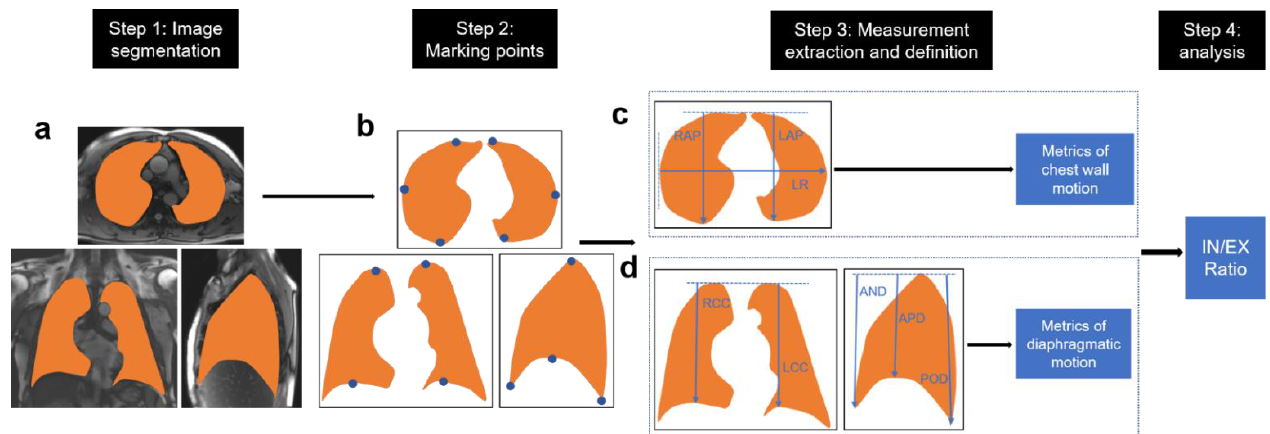
Figure 2. The flowchart of MR image processing and Measurements. MR image segmentation ( a ). Marking referenced points ( b ). Measurements extraction and definition ( c , d ). RAP, the anterior– posterior distance of right lung on the transversal plane; LAP, anterior–posterior (AP) distance of left lung on the transversal plane; LR, the left–right distance on the transversal plane; RCC, the cranial–caudal distance of right lung on coronal plane; LCC, the cranial–caudal distance of left lung on coronal plane; AND, the distance between the lung apex and anterior diaphragm on sagittal plane; APD, the distance between the lung apex and diaphragm apex on sagittal plane; POD, the distance between the lung apex and posterior diaphragm on sagittal plane. IN, inspiration. EX, expiration.